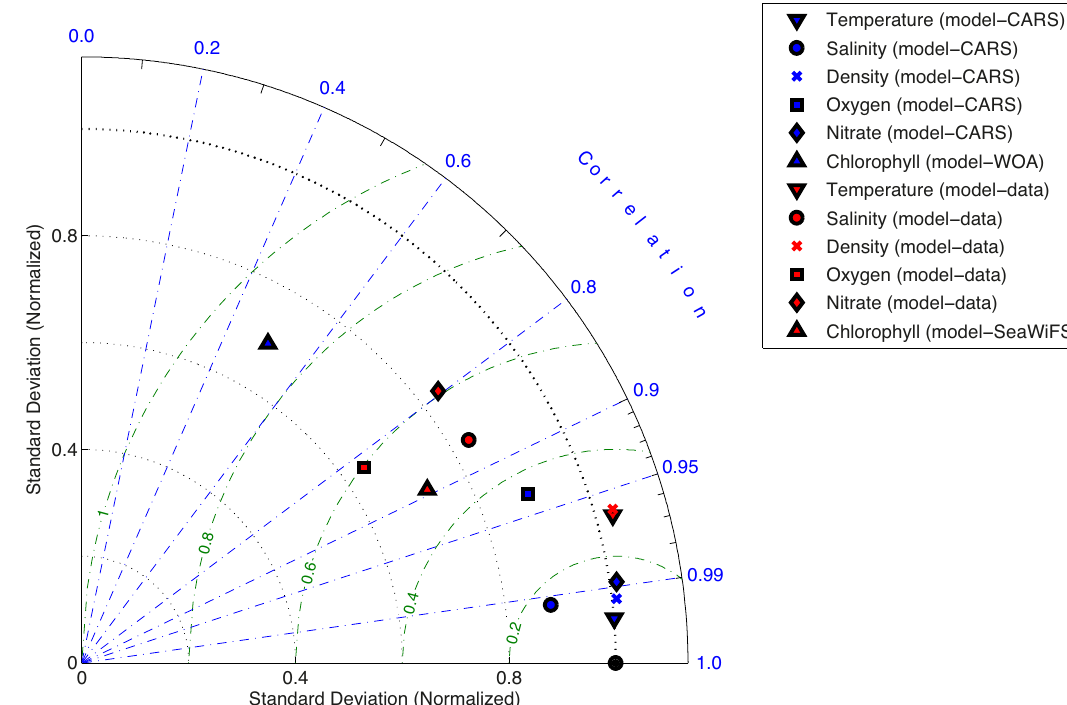
Fig. 2. Taylor diagram for temperature, salinity, density, oxygen, nitrate and chlorophyll concentrations. The radial distance from the origin is proportional to the standard deviation of a pattern (normalized by the standard deviation of the data: in situ, satellite or climatological data). The green dashed lines measure the distance from the reference point (the data; black filled circle in the diagram) and indicate the RMS error. The correlation between both fields is given by the azimuthal position of the test field. The statistics use data from annual climatologies (CARS 2006 and 2009, WOA 2001 and SeaWiFS) and from various cruises (summarized here as “in situ”; see details in Gutknecht et al., 2013). For comparison with annual climatologies, simulated fields were averaged using the 8 last years of simulation. For comparison with in situ data, simulated fields were monthly averaged, and we used the monthly mean corresponding to the cruise (see details in Gutknecht et al.,